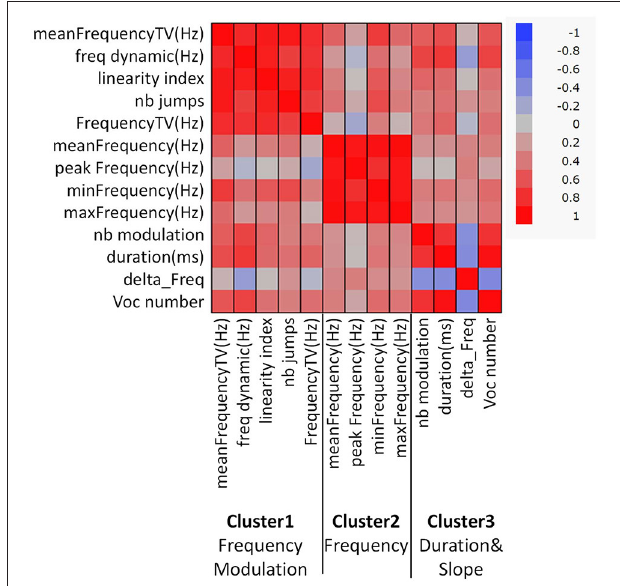
FIGURE 1 | Correlation heatmap of 13 acoustic parameters and clustering with the VARCLUS procedure using orthoblique rotation (JMP, version 14.0, SAS Institute, Cary, NC, USA). Three representative clusters were obtained, as follows: Cluster 1, Frequency modulation; Cluster 2, Frequency; and Cluster 3, Duration and